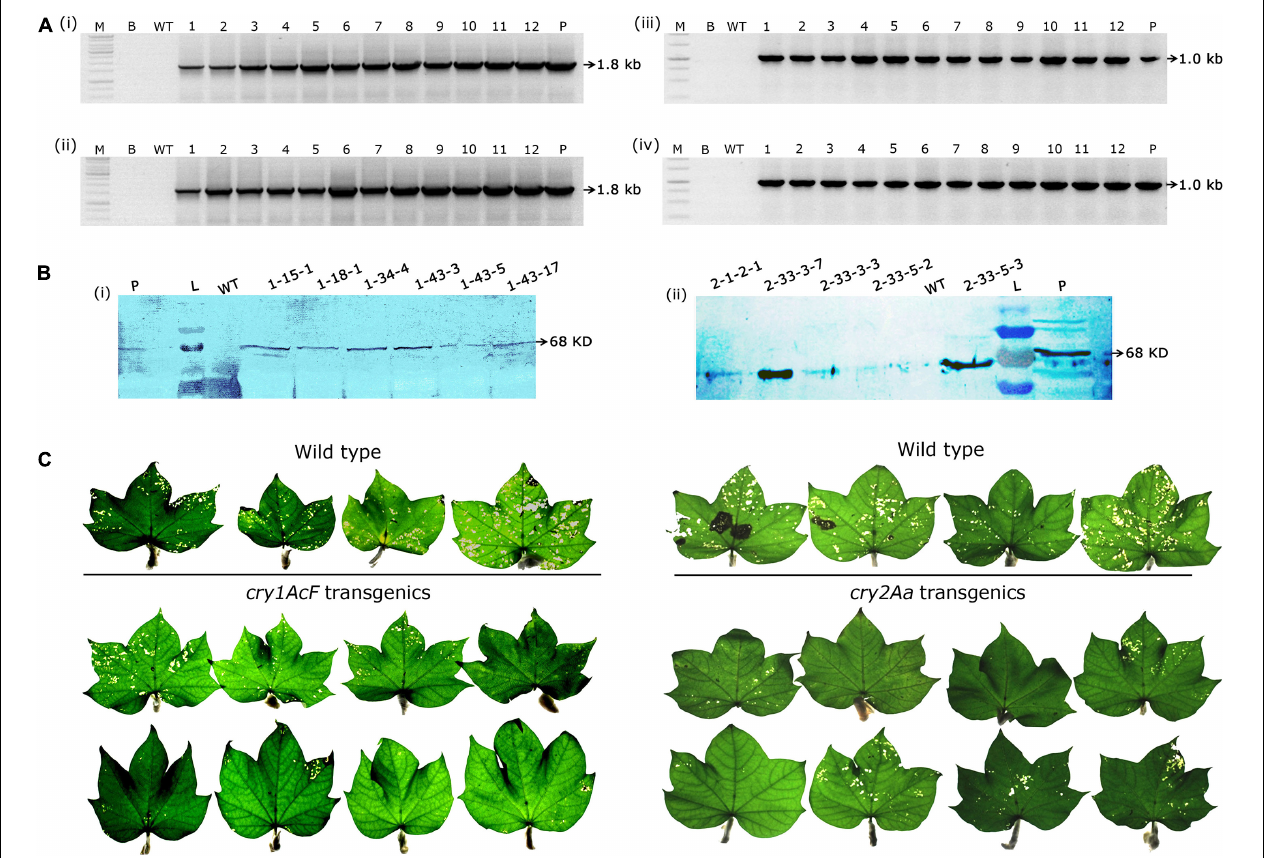
FIGURE 4 | Molecular analysis of transformants in T 2 generation. (A) PCR analysis of T 2 generation progeny plants for the amplification of (i,ii) 1.8 Kb cry1AcF gene and (iii,iv) 1.0 Kb cry2Aa gene. Lane M – 1 Kb Ladder (Thermo Scientific), Lane B – water blank (all PCR components without template DNA), Lane WT– wild type (100 ng), and Lanes 1–12 of (i,ii) two progeny plant of events–1-15-1, 1-18-1, 1-18-3, 19-1, 1-26-1, 1-26-2, 1-34-2, 1-34-3, 1-34-4, 1-43-3, 1-43-5, and 1-43-17, and Lanes 1–12 of (iii,iv) eight progeny plant of events–2-1-2, 2-33-3, and 2-33-5. Lane P–positive control (binary vector) pBinAR cry1AcF and cry2Aa, respectively. (B) Western blot analysis of selected transgenic plants harboring (i) cry1AcF and (ii) cry2Aa . Lane L – pre-stained protein ladder, Lane WT – wild type, Lanes L – pre-stained protein ladder, transgenic plants, and Lane P – purified protein of cry1AcF and cry2Aa (30 ng). (C) Assessment of the performance of wild type and transgenic plants in detached leaf bioassay challenged with Helicoverpa